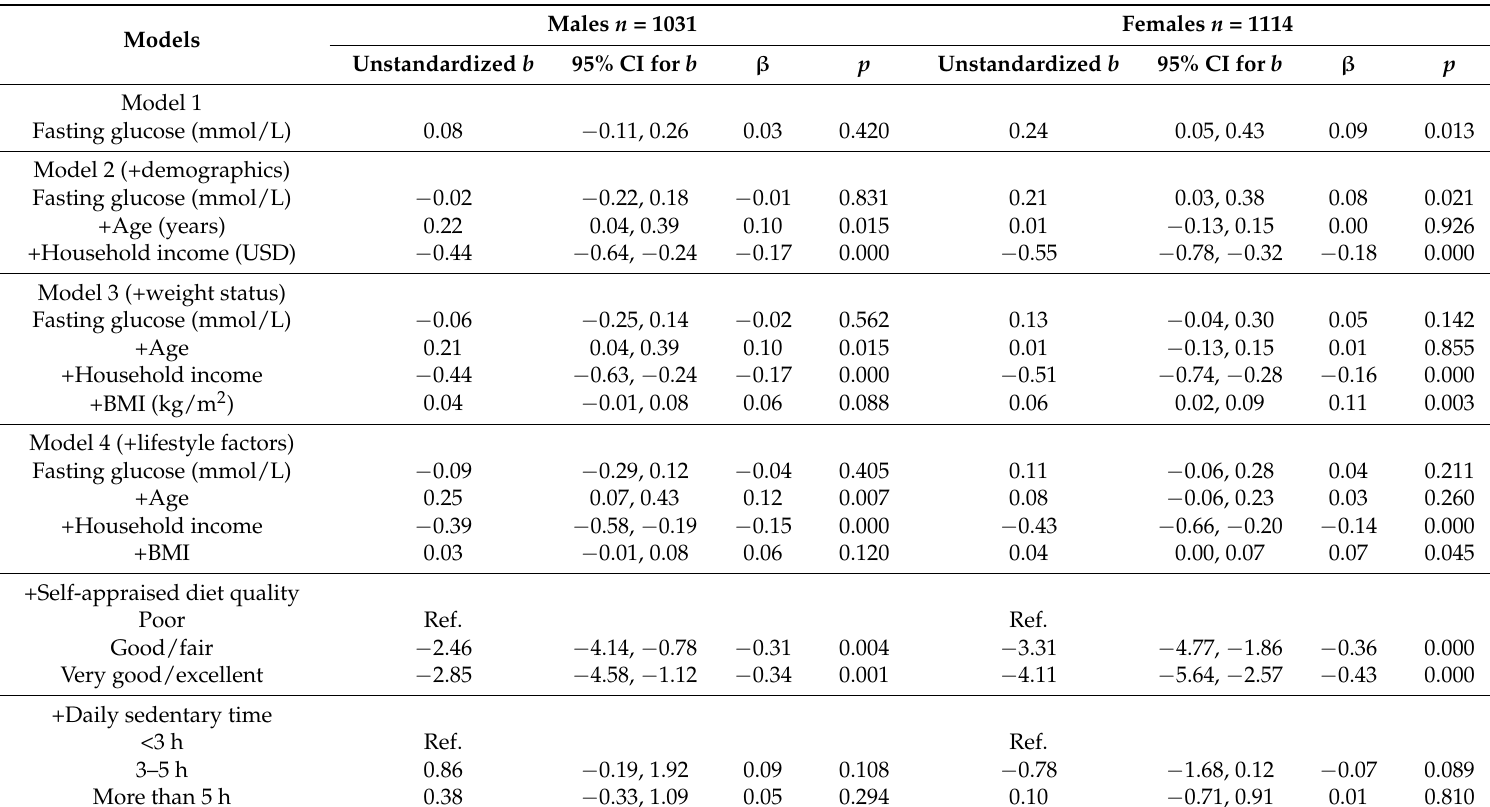
Table 2. Unstandardized ( b ) and standardized ( β ) coefficients from linear regression analyses for depressive symptoms (DV) and fasting glucose (mmol/L) (IV), unadjusted and adjusted for age, gender, income, BMI, diet, time spent sedentary, weighted to account for sampling strategy.